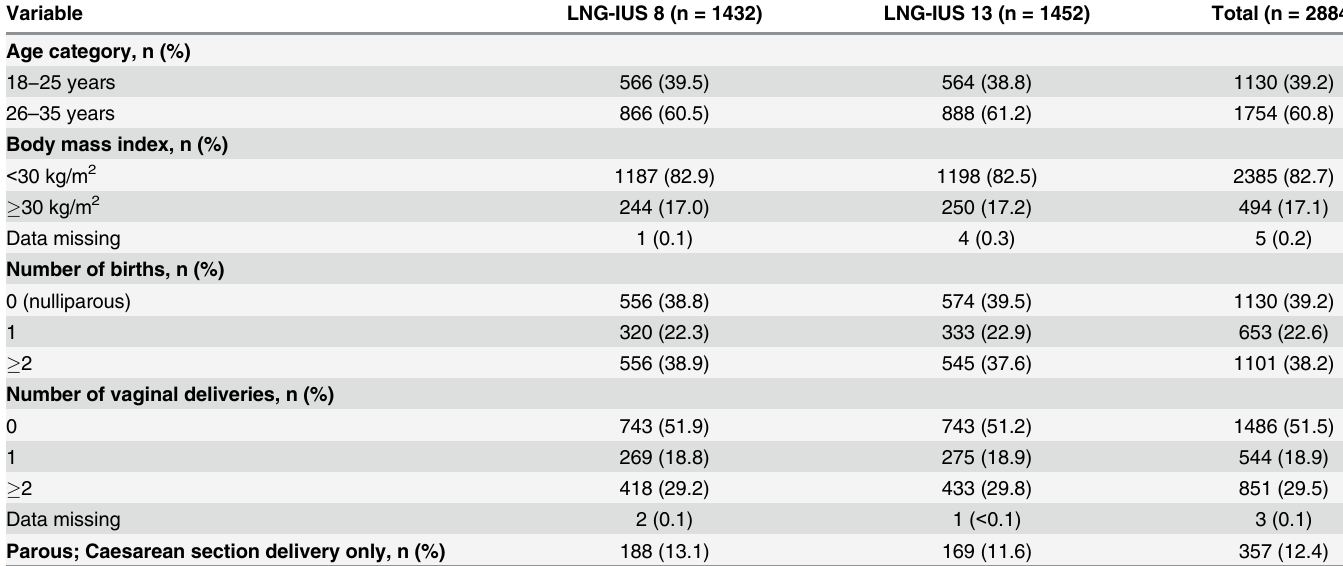
Table 1. Baseline Characteristics (Full Analysis